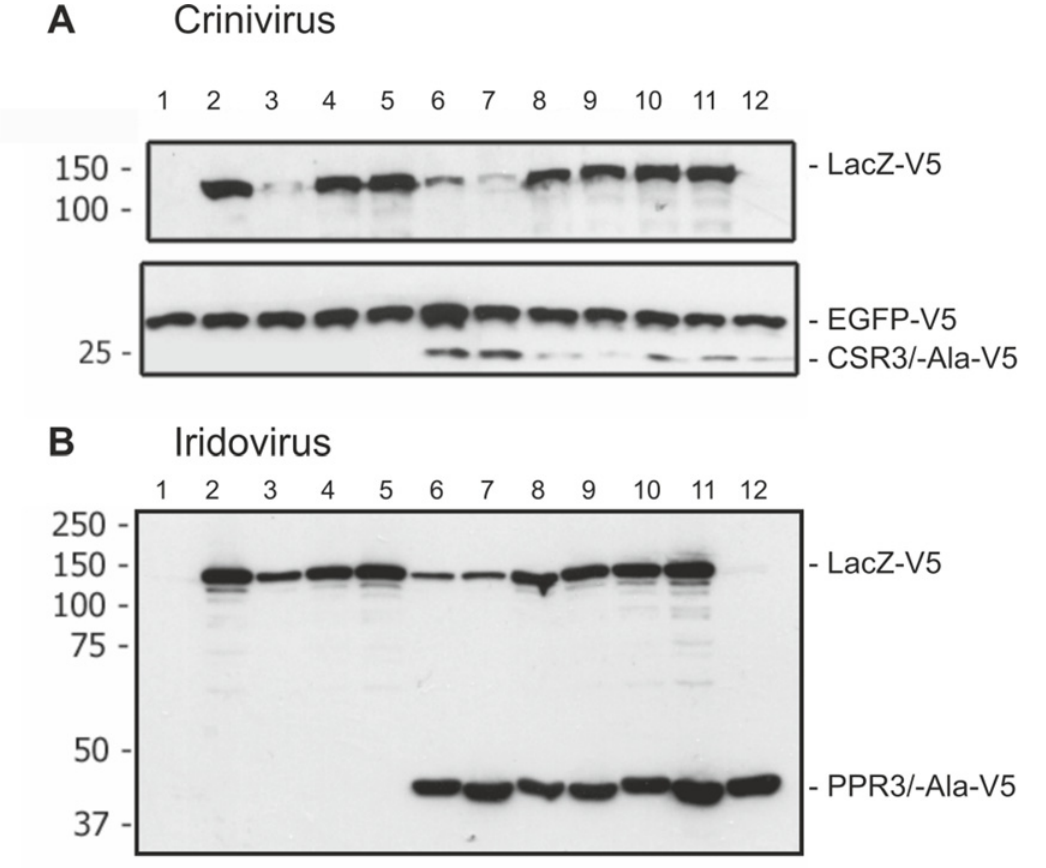
Fig 6. Immunoblot analysis of proteins in Drosophila melanogaster S2 cells transfected to co-express LacZ and viral RNase III proteins. S2 cells were transfected to co-express sense and antisense transcripts of LacZ to silence LacZ expression, and they were additionally co-transfected to express ( A ) CSR3 or CSR3-Ala (Crinivirus) or ( B ) PPR3 or PPR3-Ala (Iridovirus) and tested for their ability to suppress LacZ silencing. In some experiments, GFP was co-expressed as an internal control to verify similar levels of protein expression, as shown in A. All genes were expressed under a metallothionein promoter, which allowed simultaneous induction of expression of all genes by treatment of cultures with CuSO 4 . Cells were harvested for analysis 72 h post-induction. All proteins were expressed with the V5 tag fused to the C-terminus and detected by immunoblotting using monoclonal anti-V5. Co-expression of LacZ from two plasmids in an attempt to induce sense-mediated silencing (lane 4, both panels) or co-expression of LacZ and antisense luciferase ( luc ) transcripts (lane 5 in both panels) had no significant effect on LacZ expression level. In contrast, LacZ expression was reduced significantly in the cells co-transfected with LacZ and the anti-LacZ construct (lanes 3, 6 and 7), irrespective of whether CSR3 or CSR3-Ala (lanes 6 and 7 in panel A) or PPR3 or PPR3-Ala (lanes 6 and 7 in panel B) were co-expressed in the same cells. These results indicated that the tested viral proteins could not suppress antisense-mediated gene silencing in D . melanogaster . S2 cells were transfected or co-transfected for expression of the following constructs. “ RNase III ” refers to CSR3 (panel A) and PPR3 (panel B): lane 1, an empty plasmid; lane 2, LacZ; lane 3, LacZ and antisense-LacZ; lane 4, LacZ and LacZ; lane 5, LacZ and antisense-luc; lane